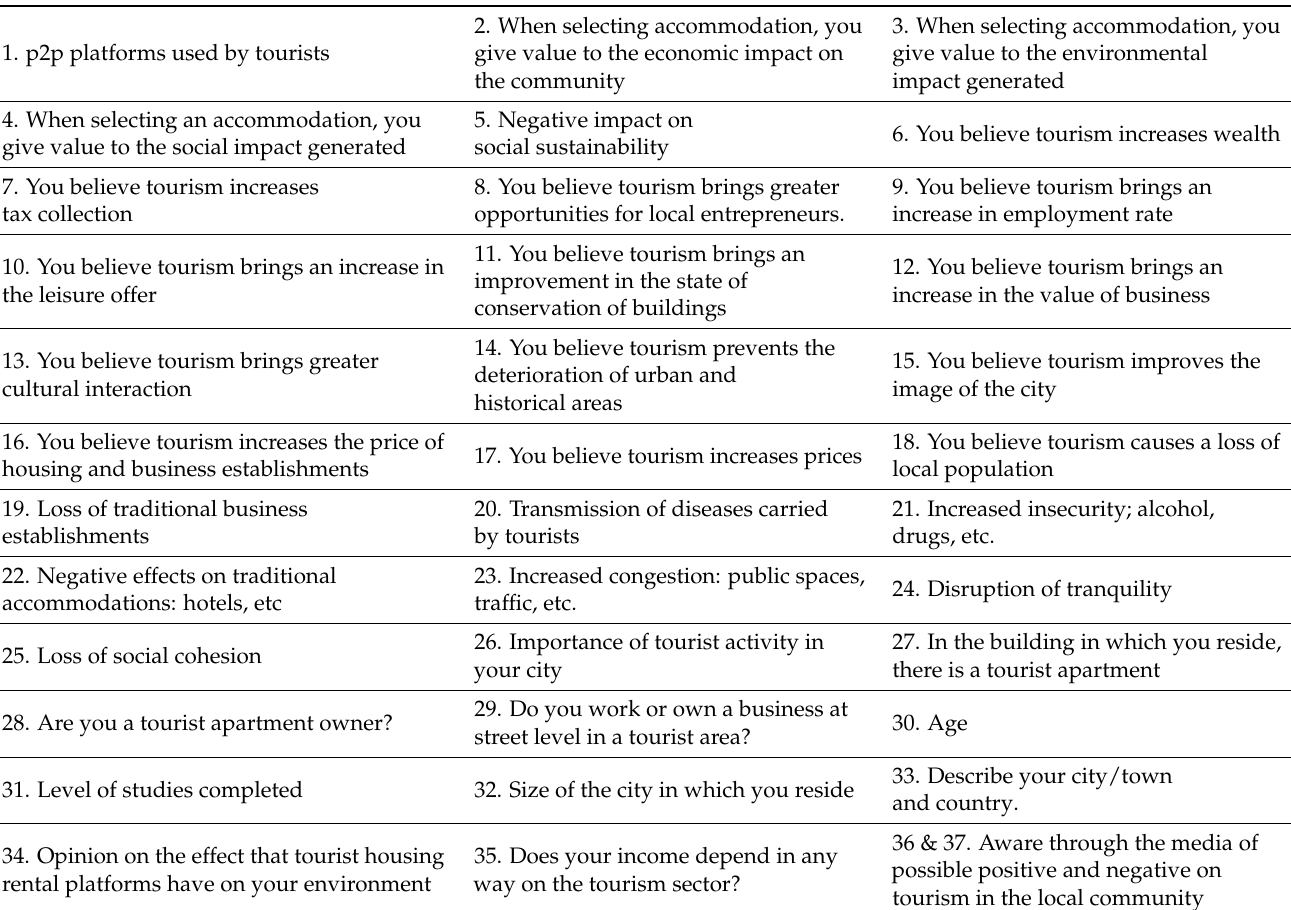
Table 1. Key questions formulated in the